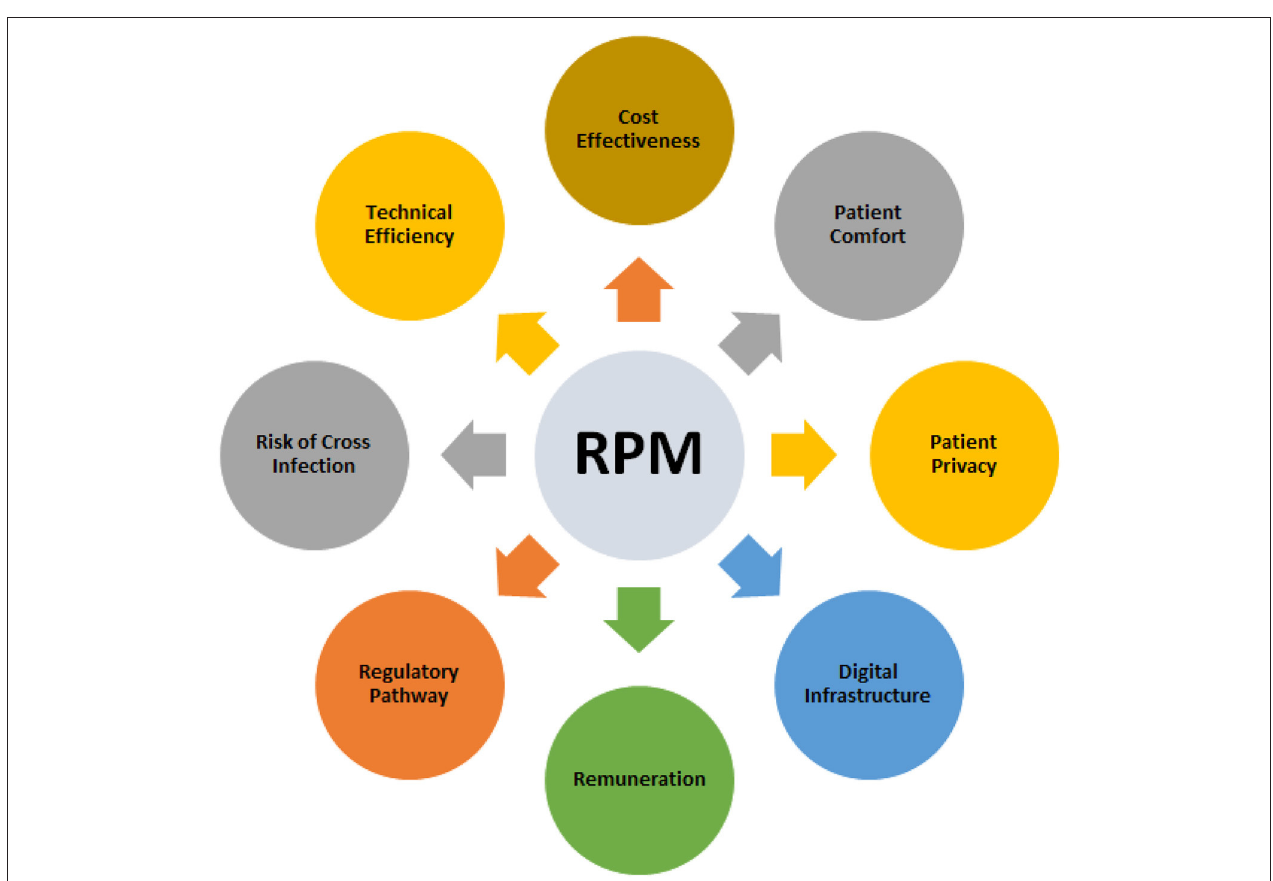
FIGURE 6 | Eight key factors for choosing RPM and sensor technologies.